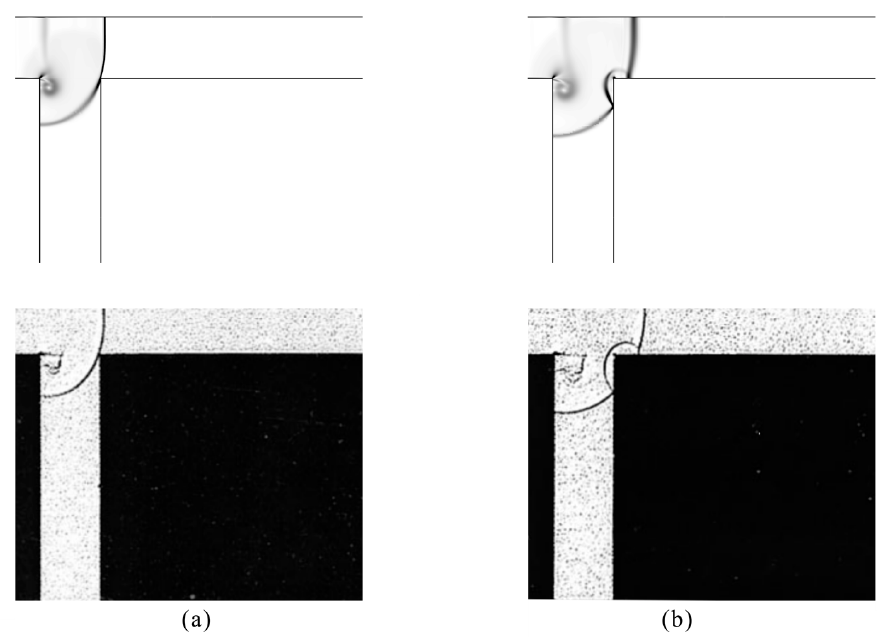
Figure 4. Comparison of between the numerical ( top ) and experimental ( bottom ) schlieren images. ( a ) t = 28 μ s. ( b ) t = 40.5 μ s.